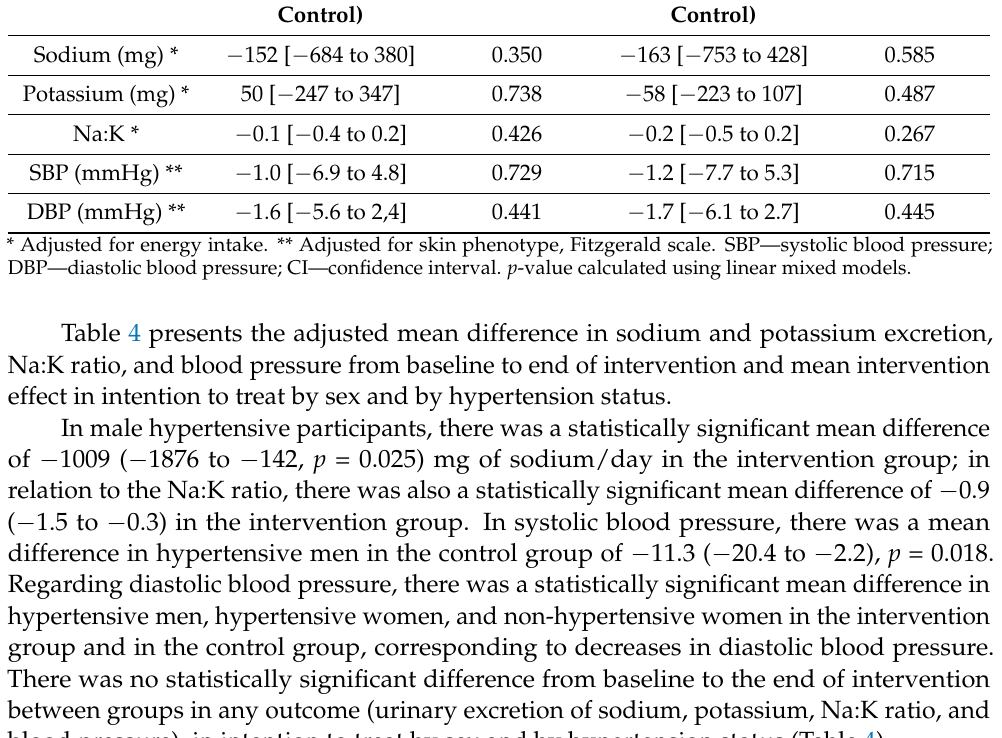
Table 3. Mean intervention effect (adjusted mean difference (intervention vs. control)) in intention-to- treat and per-protocol analysis. Intention to Treat Per Protocol Adjusted Adjusted Outcomes Difference [95%CI] Difference p -Value (Intervention vs. Control)